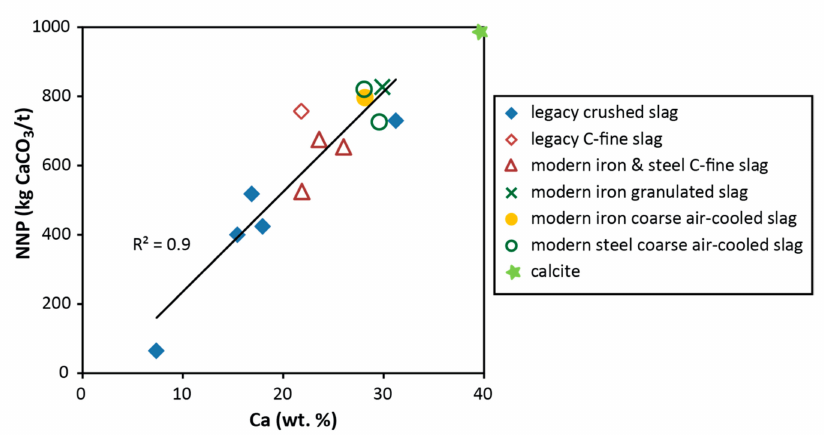
Figure 4. Bulk calcium (Ca) concentrations in weight percent (wt. %) versus Net Neutralization Potential (NNP) in kilograms CaCO 3 per ton (kg CaCO 3 / t) for ferrous slag from the Chicago-Gary area, Illinois and Indiana. Theoretical Ca concentration and NNP for calcite are shown. The linear regression line for slag data and the coe ffi cient of determination (R 2 ) are also